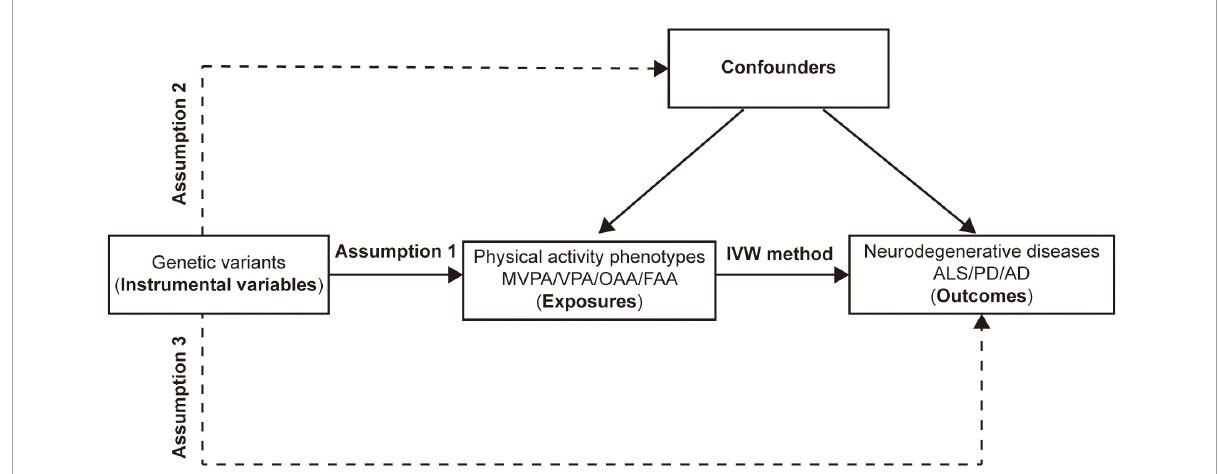
FIGURE1 Assumptions and design of the two-sample mendelian randomization in this study. Genetic variants significantly associated with physical activity phenotypes are used as instrumental variables. MVPA, Self-reported moderate-to-vigorous physical activity; VPA, Self-reported vigorous physical activity; OAA, Overall acceleration average; FAA, Fraction of accelerations > 425 milli-gravities; IVW, Inverse variance weighted; ALS, amyotrophic lateral sclerosis; PD, Parkinson’s disease; AD, Alzheimer’s